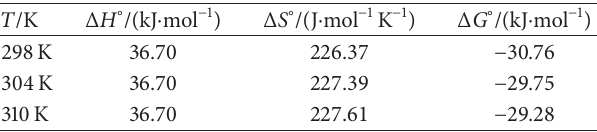
Table 2: Thermodynamic parameters of the interaction between Hyp and HAS.